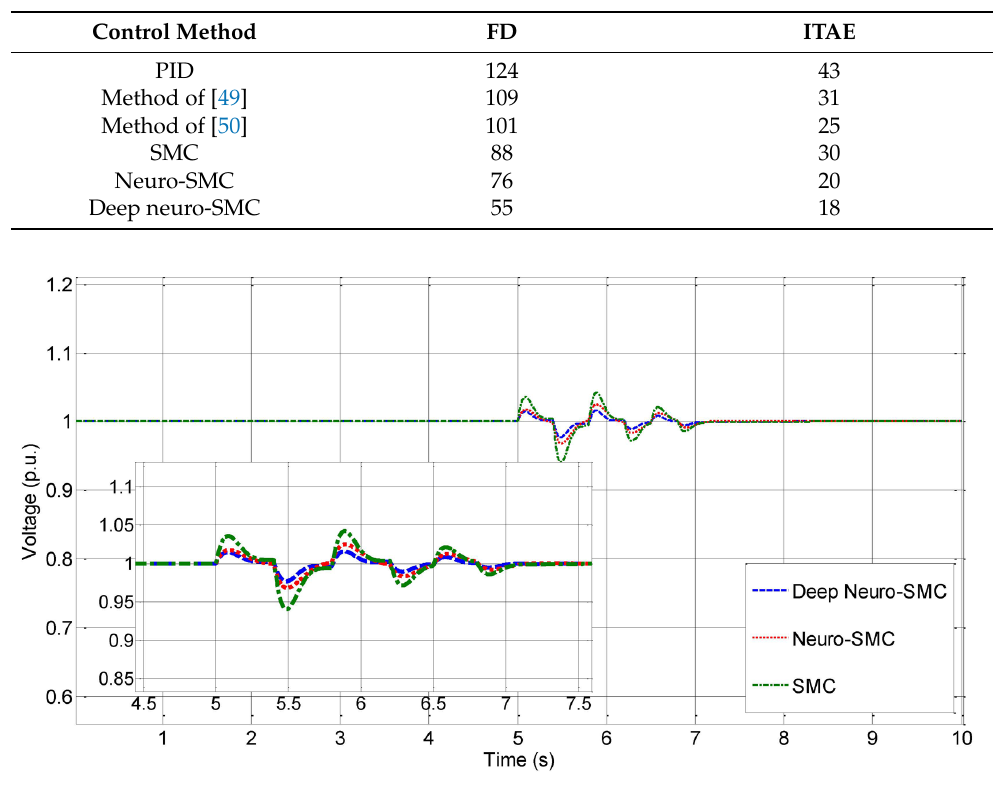
Figure 9. Bus number 5 voltage diagram (first case).